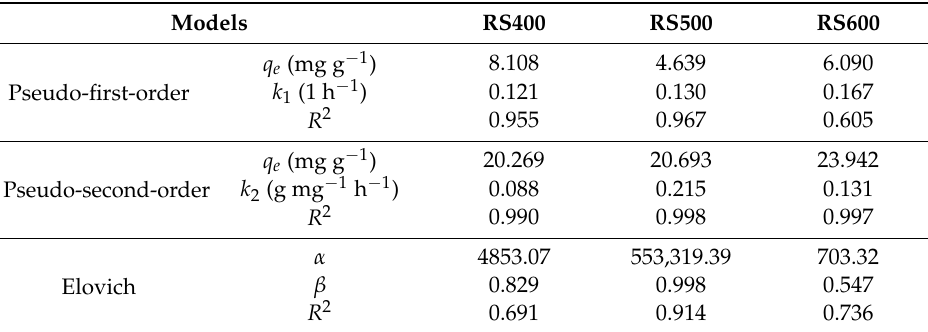
Table 2. Kinetic parameters for adsorption of